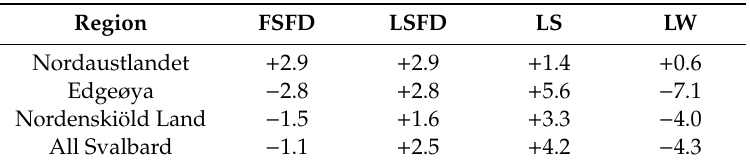
Table 2. Summary of the decadal trends in first snow-free day, last snow-free day, length of summer and length of winter, for the three regions Nordaustlandet, Edgeøya and Nordenskiöld Land as well as the average for the whole of